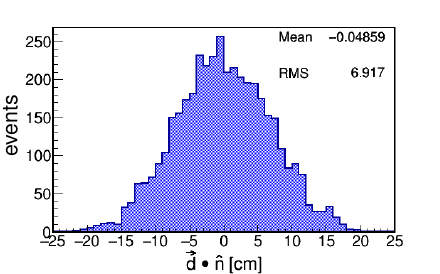
Figure 3. Distribution of the shortest distance ( d ) between the o-Ps decay plane and the center of the J-PET detector (see Fig. 2), calculated as a projection to the normal of the decay plane (ˆ n ). Extreme values allow for rejection of artificial decay planes obtained for accidental 3 γ